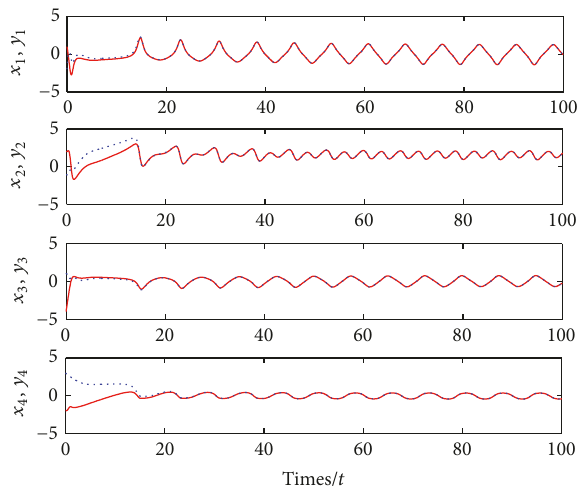
Figure 8: The figure shows that the states, 𝑥 1 , 𝑥 2 , 𝑥 3 , 𝑥 4 , synchro- nize the states, 𝑦 1 , 𝑦 2 , 𝑦 3 , 𝑦 4 ,